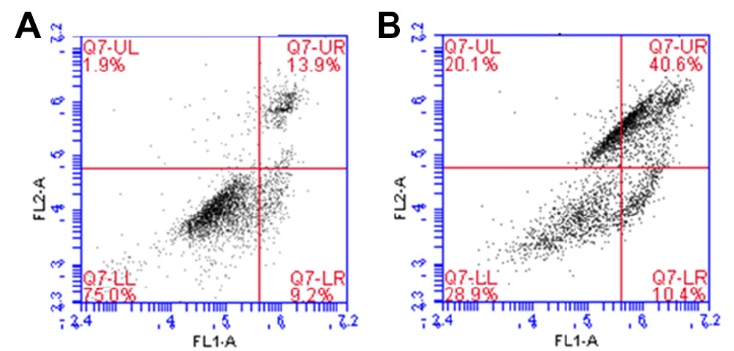
Figure 9. Flow cytometry results via annexin V staining of ( A ) untreated cells and ( B ) HECP2k 10X@Dox/siRNA complexes-treated cells. (FL1: Alexa Fluor 488, FL2: PI).